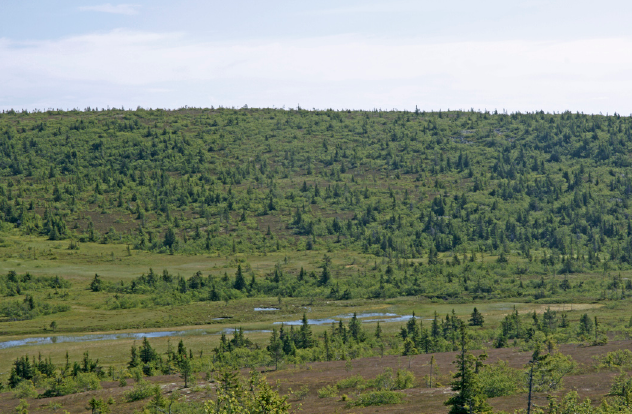
Figure 23: Low mountain at the eastern continental periphe- ry of the mountain chain. According to old maps and recent tree aging, this and similar mountains supported caps of treeless alpine tundra in the early 20th century. In this case, spruce is the main colonist. Mt. Fjällskaftet. 22 July